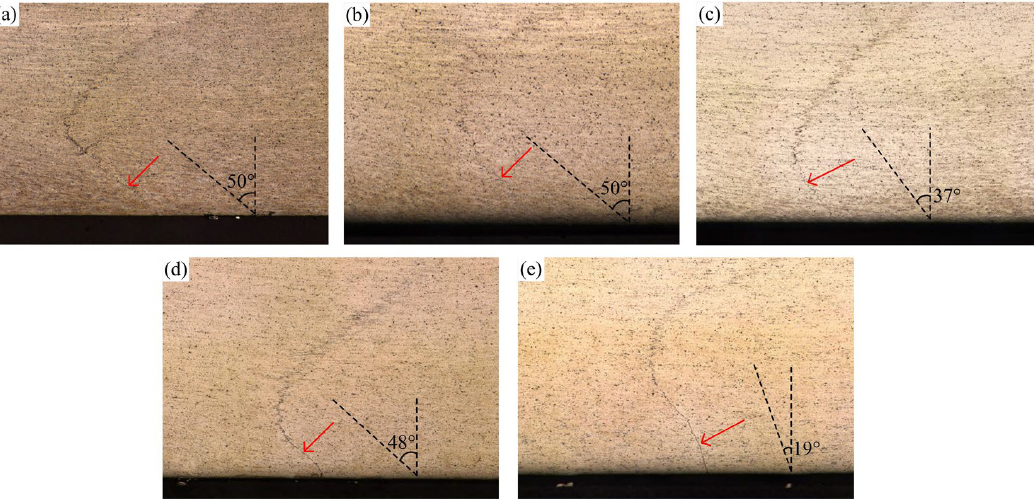
Figure 10. Magnified incomplete-penetration defects: ( a – e ) corresponding to the featured region A–E in Figure 9.